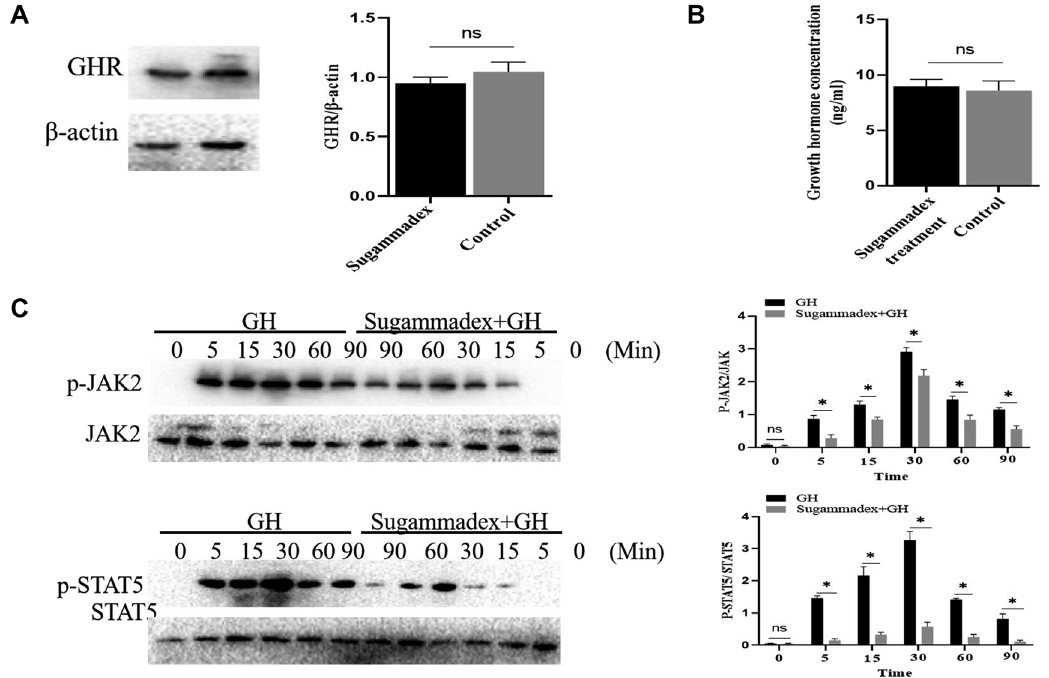
Figure 2: Sugammadex suppressed GH-induced signaling. (A) Sugammadex has no effect on growth hormone receptor (GHR) expression in vivo . (B) Endogenous growth hormone (GH) levels were assessed by ELISA assay. (C) Janus kinase 2 (JAK2)-signal transducers and activators of transcription 5 (STAT5) activation was signi fi cantly inhibited by Sugammadex treatment in vivo . Data are represented as mean ± standard deviation (SD). The asterisk indicates that the difference is statistically signi fi cant (p-value